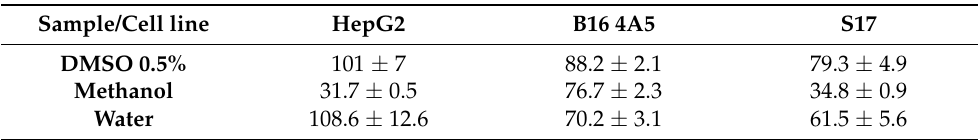
Table 6. Cellular viability (%) of Nepeta baytopii extracts on HepG2, B16 4A5 and S17 cell lines applied at the concentration of 100 µ g/mL.